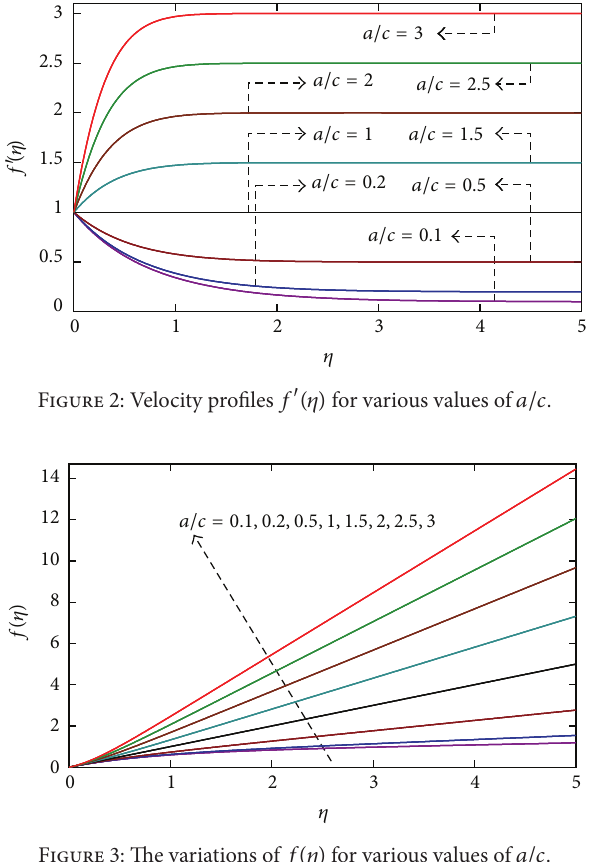
with the boundary conditions